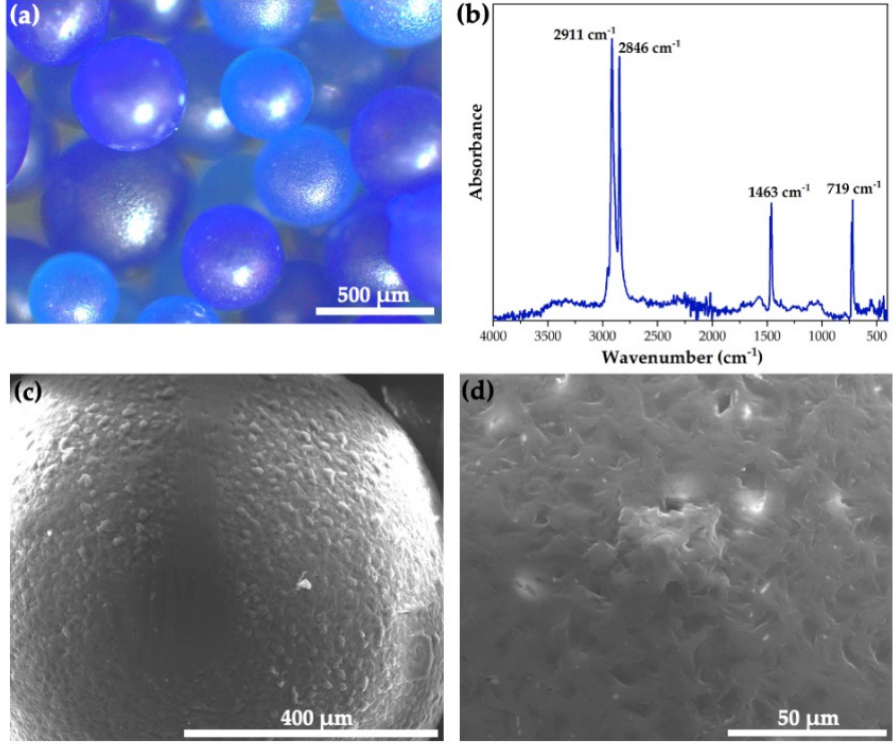
Figure 1. ( a ) Optical micrography, ( b ) FTIR spectrum, and ( c , d ) SEM micrographs of the as − extracted HDPE MPs.